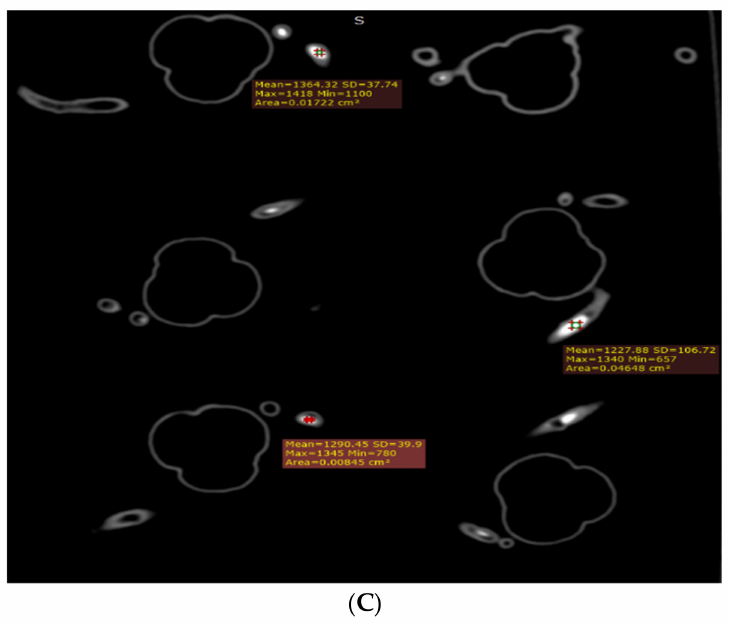
Figure 7. Measurement of CT attenuation at the simulated calcified plaques on 2D axial images ( A – C